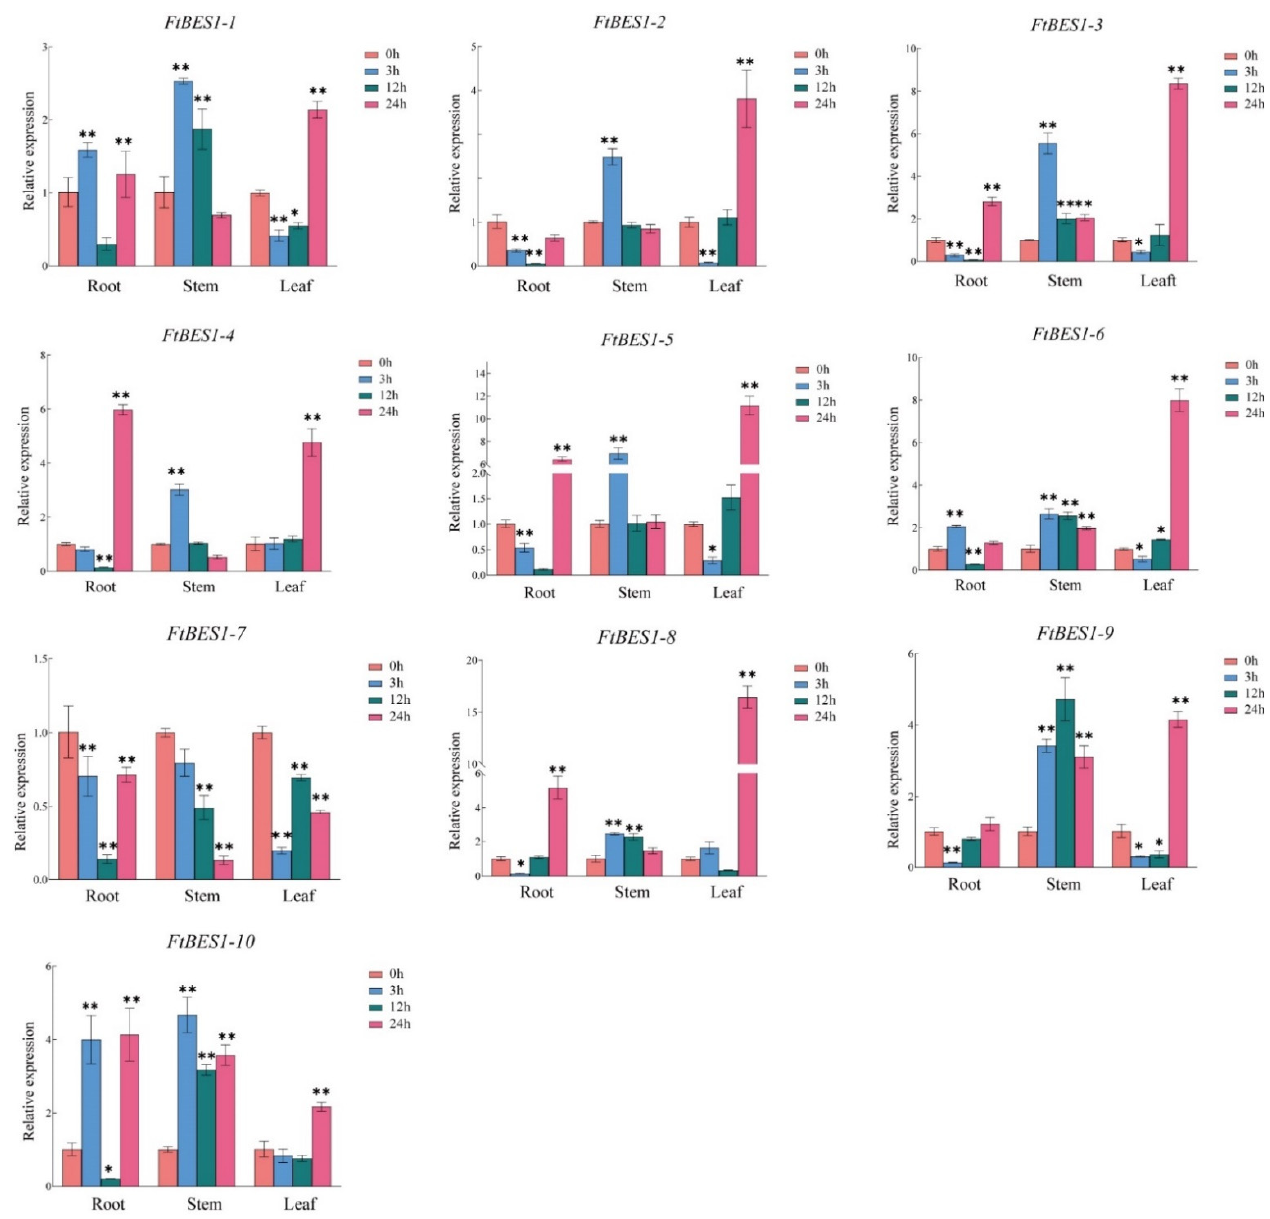
Figure 7. Expression levels of FtBES1 gene in different tissues after 100 μ M GA treatment. Different colors indicate different time of stress treatment. Three biological replicates were considered for each experiment. Error lines indicate standard errors of three independent biological replicates. * In the figure indicates significant differences calculated by t-test (* p < 0.05, ** p < 0.01).